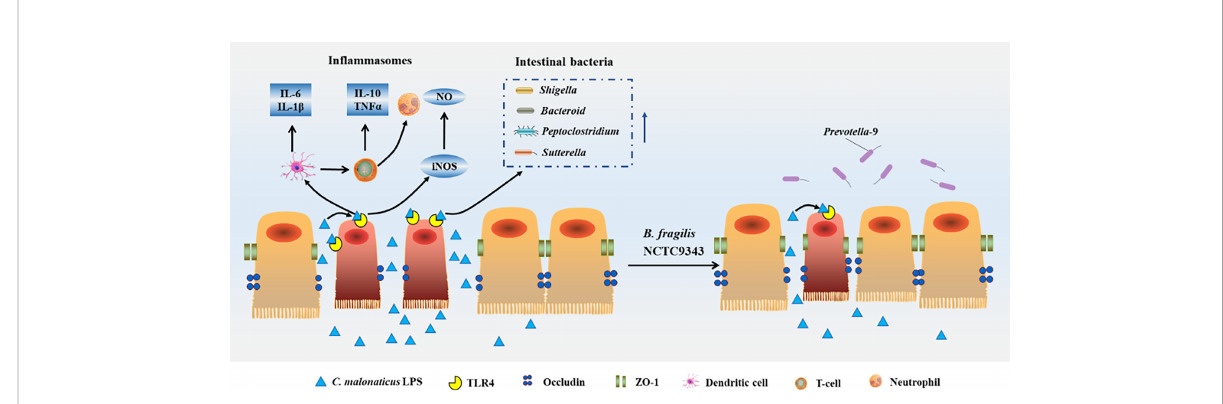
FIGURE 10 Host response caused by Cronobacter -LPS and reconstruction after B. fragilis NCTC9343